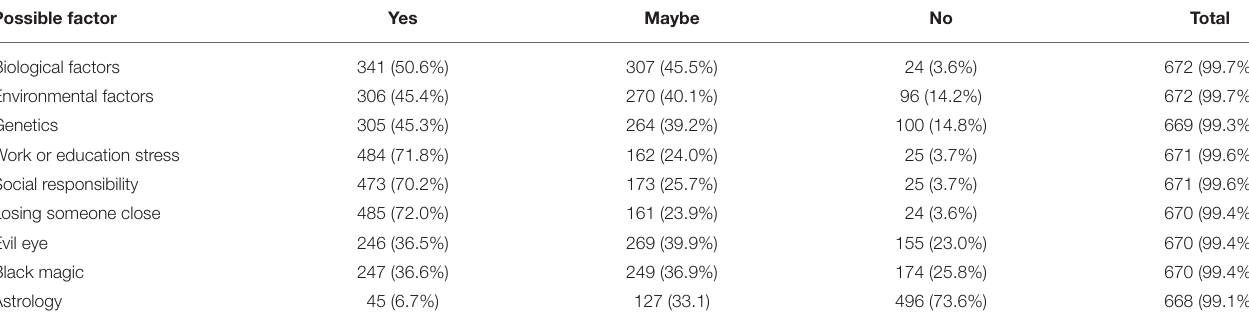
TABLE 4 | Participants perception and beliefs about the most important factor leading to psychological disorders. Possible factor